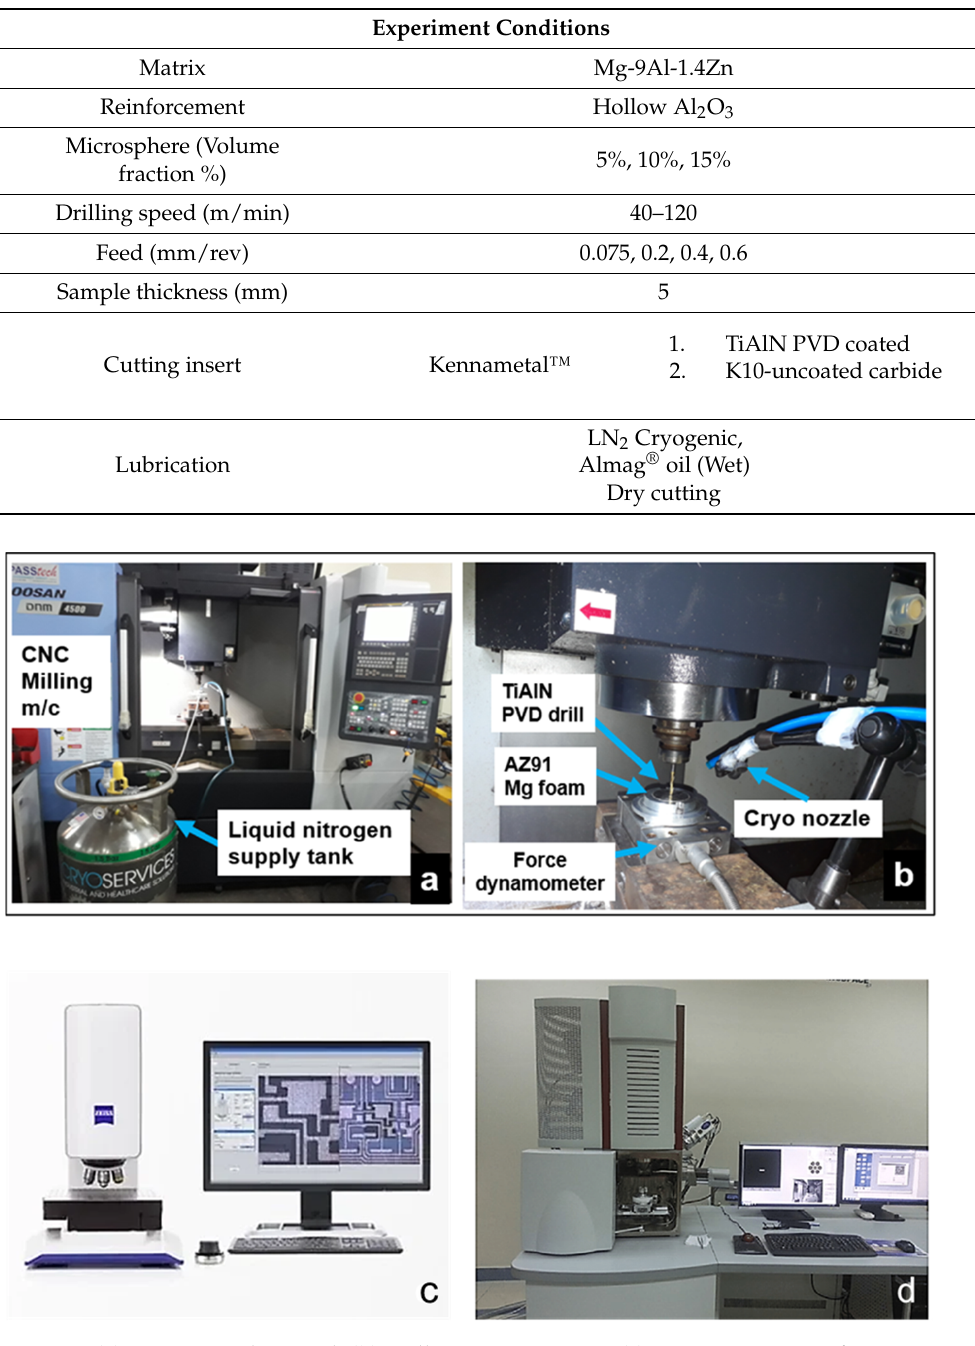
Figure 2. ( a ) Doosan machine tool. ( b ) Drilling process set up. ( c ) ZEISSS smart proof 5 microscope. ( d ) TESCAN SEM ( d ) TESCAN SEM setup.